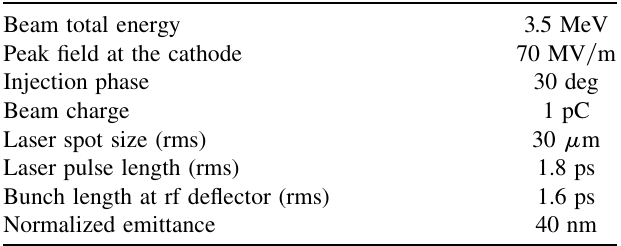
TABLE I. Pegasus photoinjector parameters for the transverse space charge dominated expansion